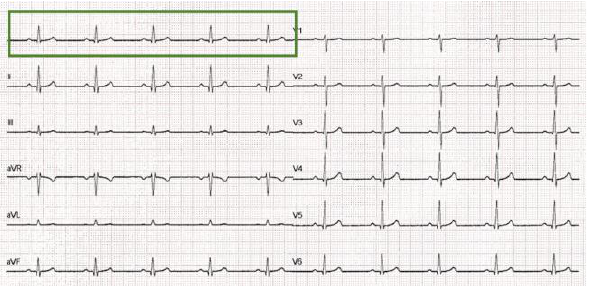
Figure 2. ECG of normal sinus rhythm (60 bpm); the green rectangle represents the printed portion